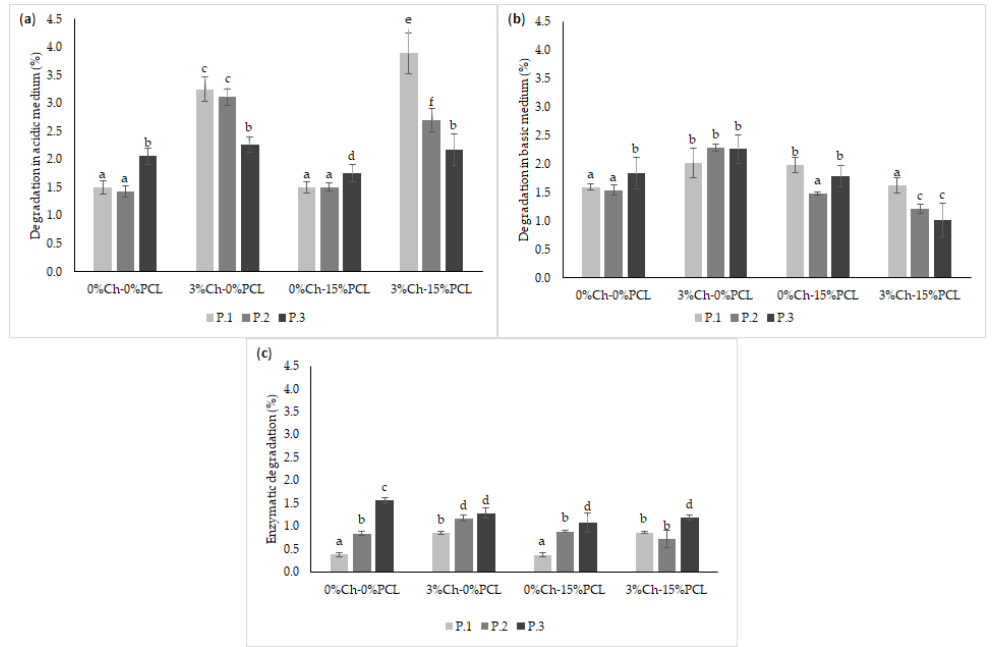
Figure 9. Degradation rate of PUs in different media. ( a ) Acidic medium (0.1 M HCl) for 90 days; ( b ) Basic medium (0.1 M NaOH) for 90 days; ( c ) Enzyme medium (esterase) for 21 days. The data are expressed as the mean ± SD (n = 3). Bars with different letters (a–f) indicate significant differences ( p < 0.05) between the polyols.